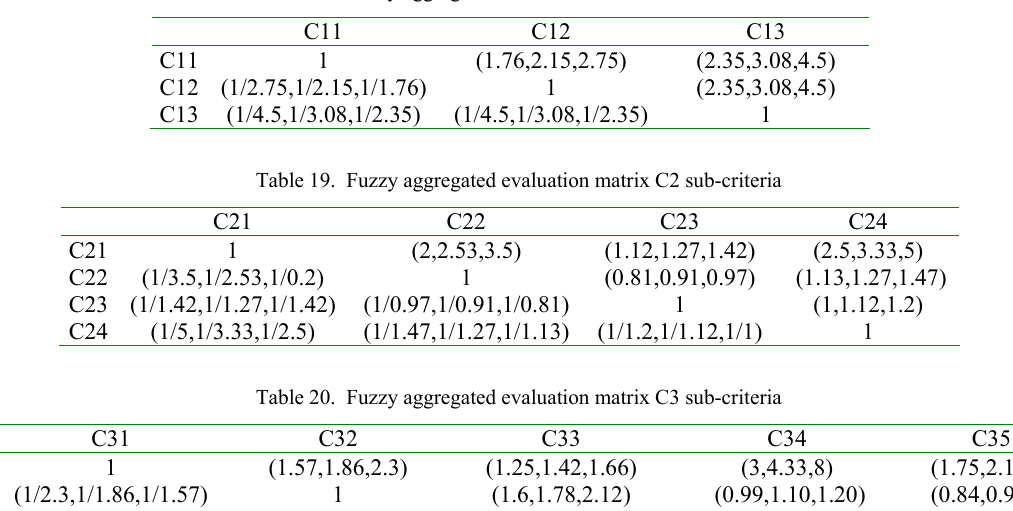
Table 18. Fuzzy aggregated evaluation matrix C1 sub-criteria